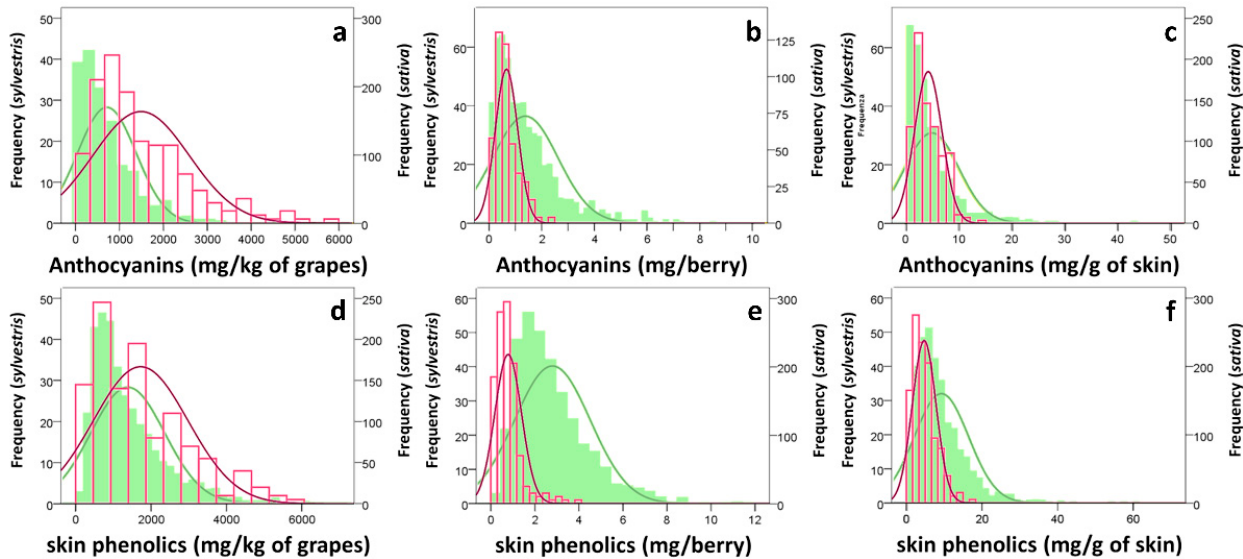
Figure 3. Anthocyanins and phenolics in skins of Vitis vinifera subsp. sylvestris (in pink) and subsp. sativa (in green). Vitis vinifera subsp. sativa data are already published in Rustioni et al. [26]. ( a ): anthocyanins (mg/kg of grapes), ( b ): anthocyanins (mg/berry), ( c ): anthocyanins (mg/g of skin), ( d ): skin phenolics (mg/kg of grapes), ( e ): skin phenolics (mg/berry), ( f ): skin phenolics (mg/g of skin).